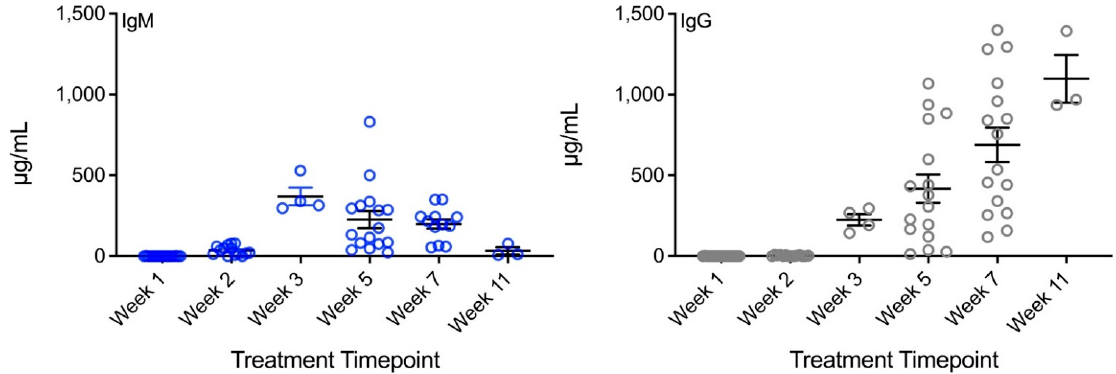
Figure 1. Subjects treated with vidutolimod develop and maintain high levels of anti-Q β antibody. Melanoma patients were treated with vidutolimod on week 1. Serum from various timepoints was assessed for anti-Q β IgM (blue circles) and IgG (grey circles) antibody by ELISA ( n = 3–16).